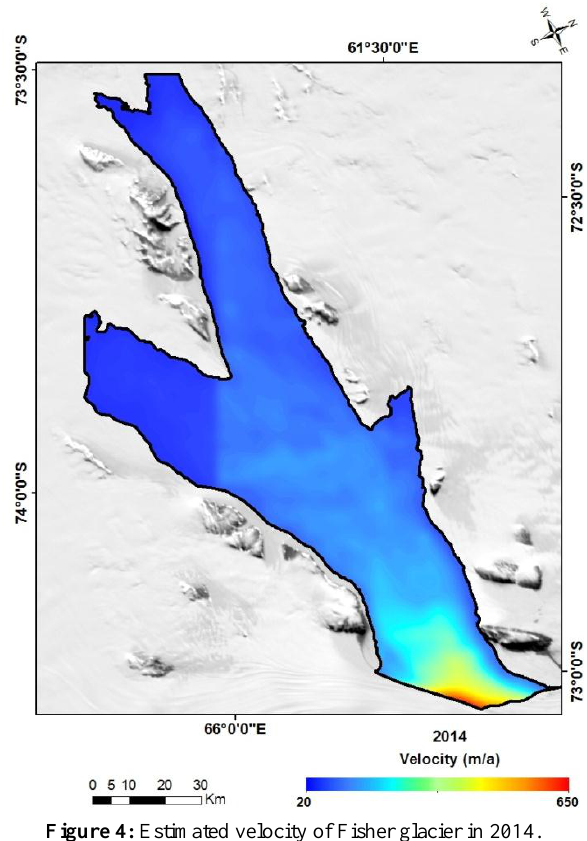
Figure 4: Estimated velocity of Fisher glacier in 2014.